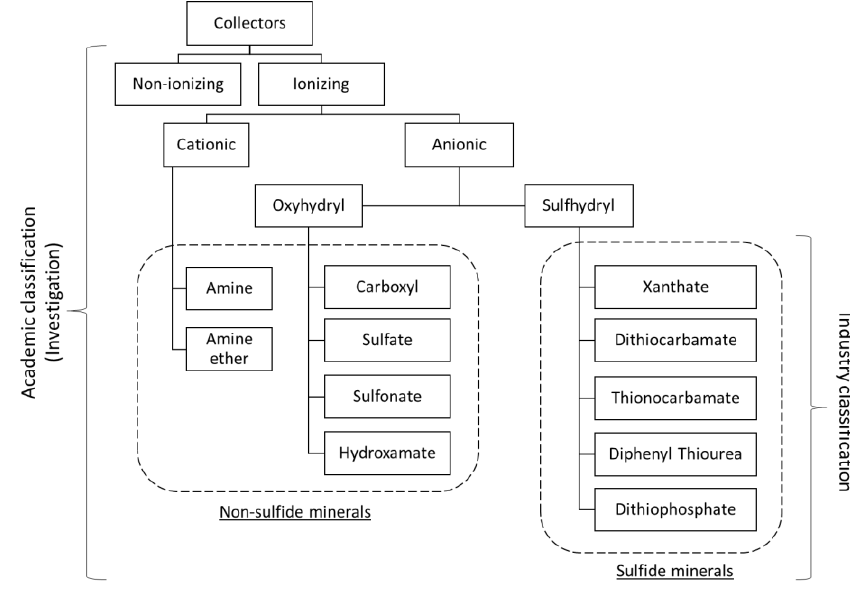
Figure 7. Classification of collectors according to their academic and industrial use.